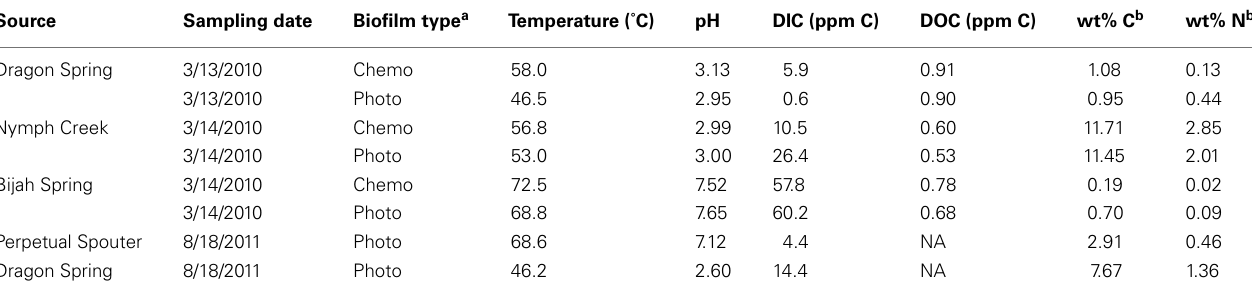
Table 1 | Physical and chemical measurements made at sampling